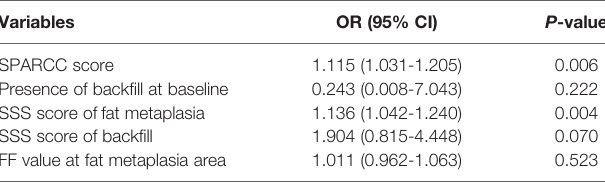
TABLE 2 | Univariate logistic regression analysis of the back fi ll progression.